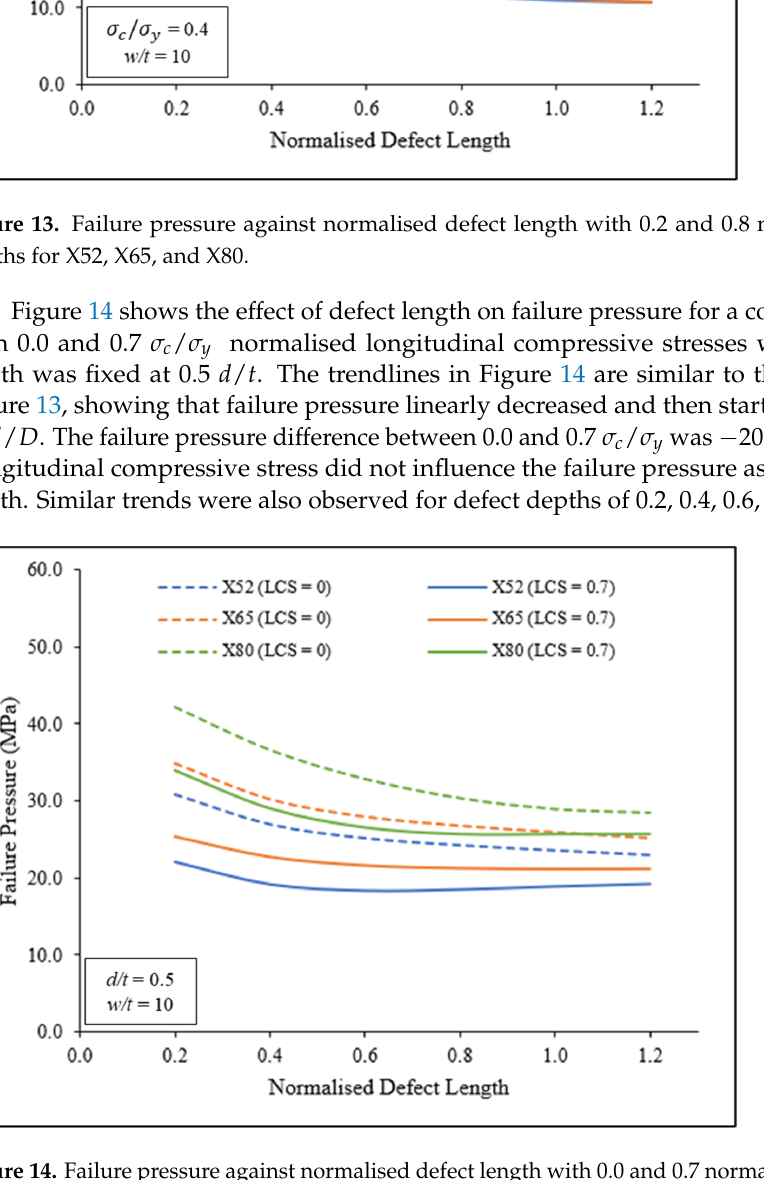
Figure 14. Failure pressure against normalised defect length with 0.0 and 0.7 normalised longitudinal compressive stresses for X52, X65, and X80.